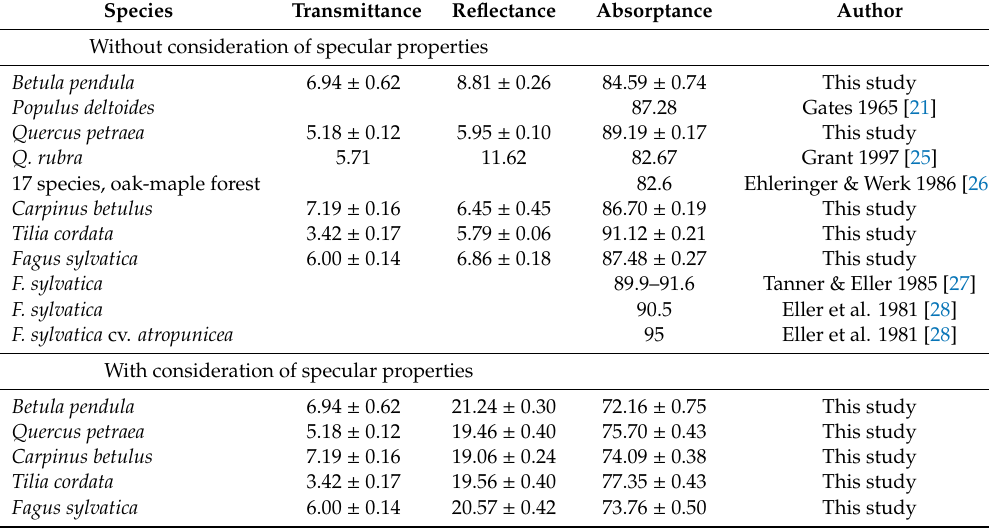
Table 6. Transmittance, reflectance and absorptance of sun leaves of di ff erent temperate broadleaf tree species in the 350–720 nm range according to di ff erent authors (in %, means ± standard error (SE)). Part of the values was read from figures. Leaves were generally measured at 90 ◦ orientation to the radiation beam (‘without consideration of specular properties’). In this study, leaves were additionally measured at an angle of 82 ◦ (i.e., with 8 ◦ inclination to the rectangular orientation) to consider specular properties of the leaf surface, which can greatly increase measured reflectance (lower table